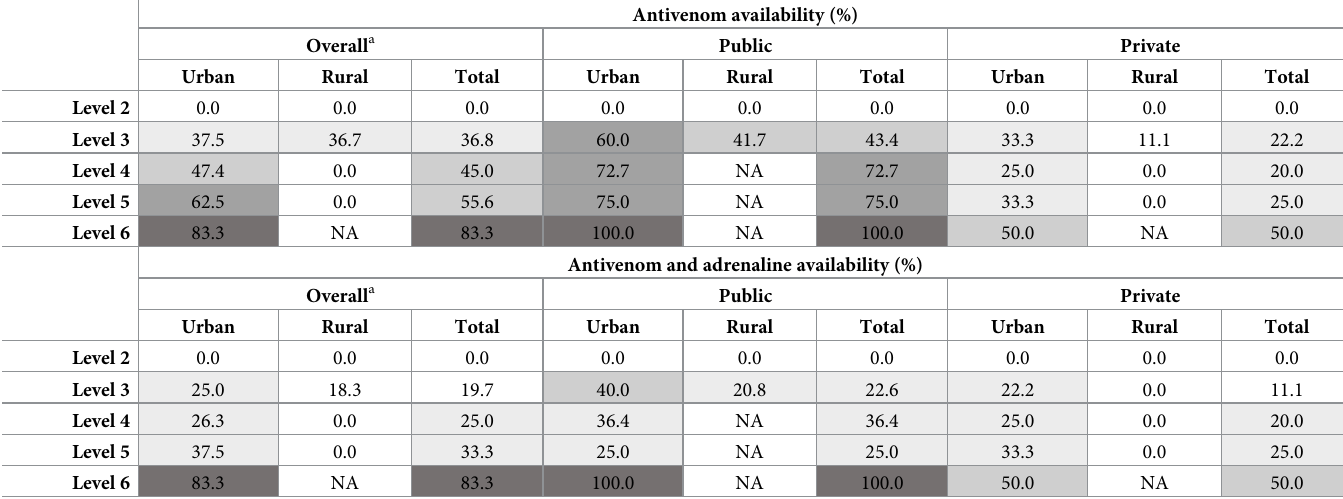
Table 3. Availability of antivenom, and antivenom and adrenaline, per level and